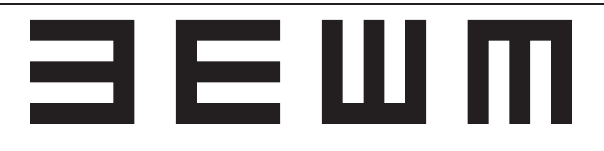
FIGURE 1 | Four orientations of Snellen E converted to “soundscape” stimuli: left, right, up, down.